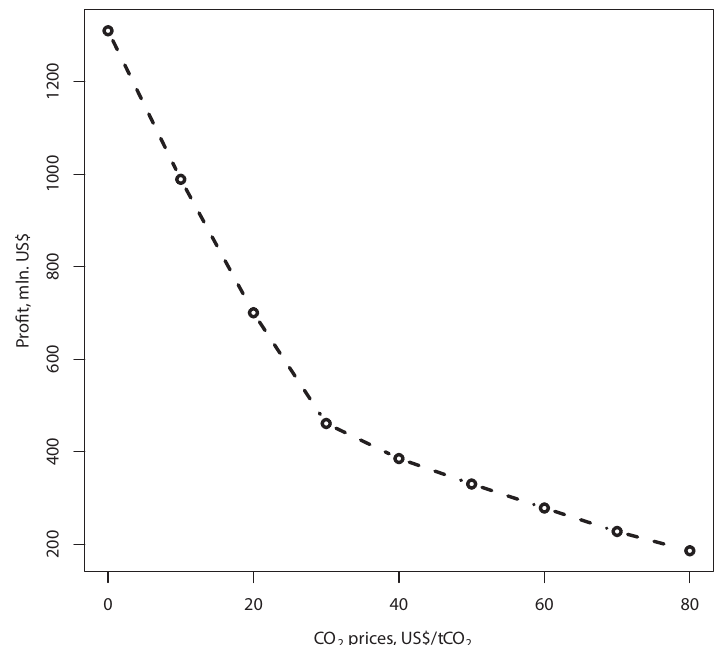
Figure 2. Annual profit of the electricity producer in the FI-REDD model with respect to growing CO 2 price, adapted from Reference